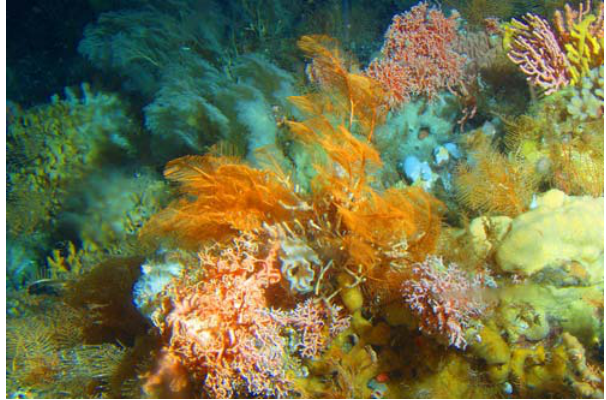
Figure 3. Diverse benthic habitat off Adak Island, Alaska, showing sponges, hydroids, and stylasterid corals of the genus Stylaster at a depth of 150 meters. Stylasterid corals are among the most important habitat-forming invertebrates in deep-sea coral ecosystems in the North Pacific [24]. Photo by Alberto Lindner/NOAA.